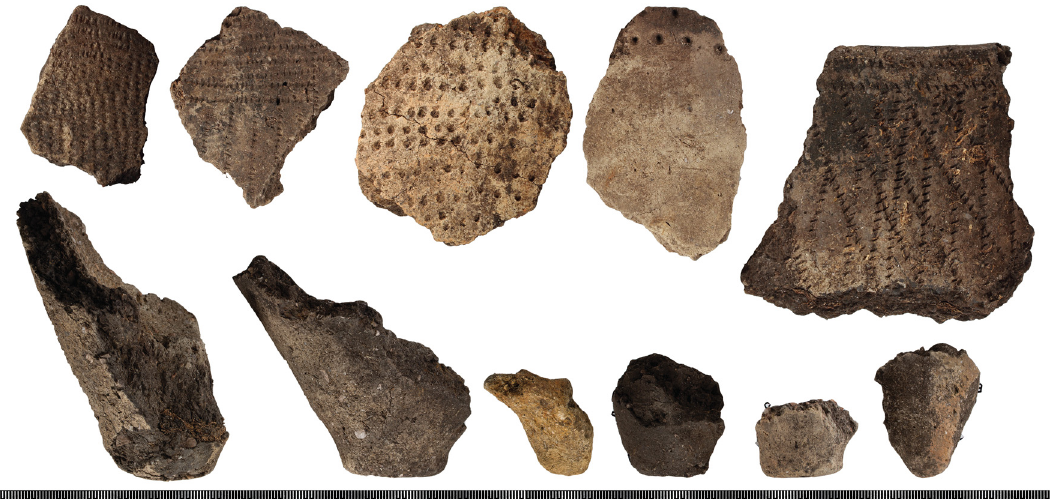
Figure 5: Sherds of coarse - grained pottery from the Alveberget site ( C61487 ) . Upper row: sherds with di ff erent types of decoration: thread, cord stamps, pits, and cord stamps in geometric lines. Lower row: selection of pointed bases, di ff erent sizes. Scale: millimeters. Photo: I. M. Berg - Hansen, © 2020 Museum of Cultural History, University of